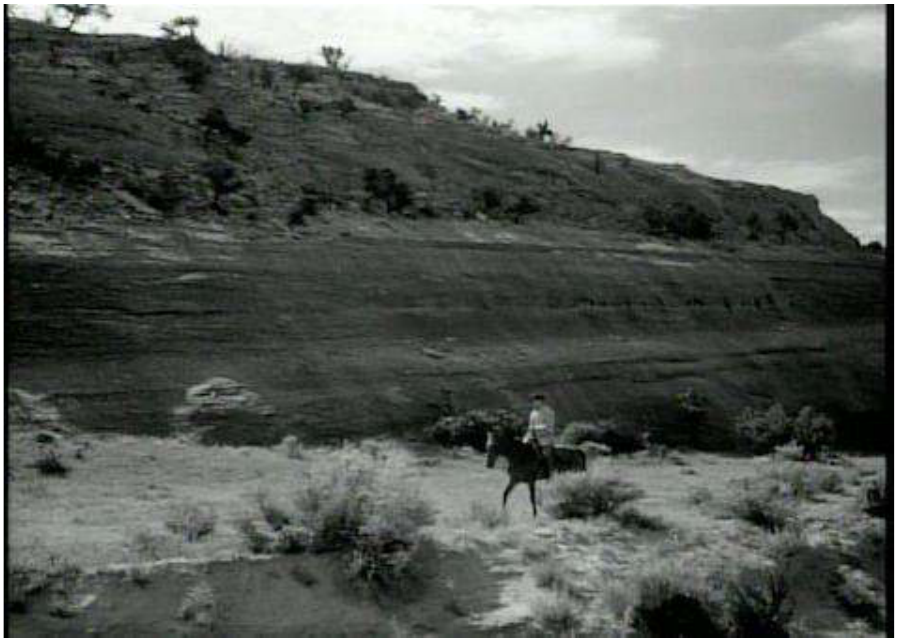
Figure 1: Mitchum in the foreground being trailed by a mysterious figure on horseback up a cliff in Pursued